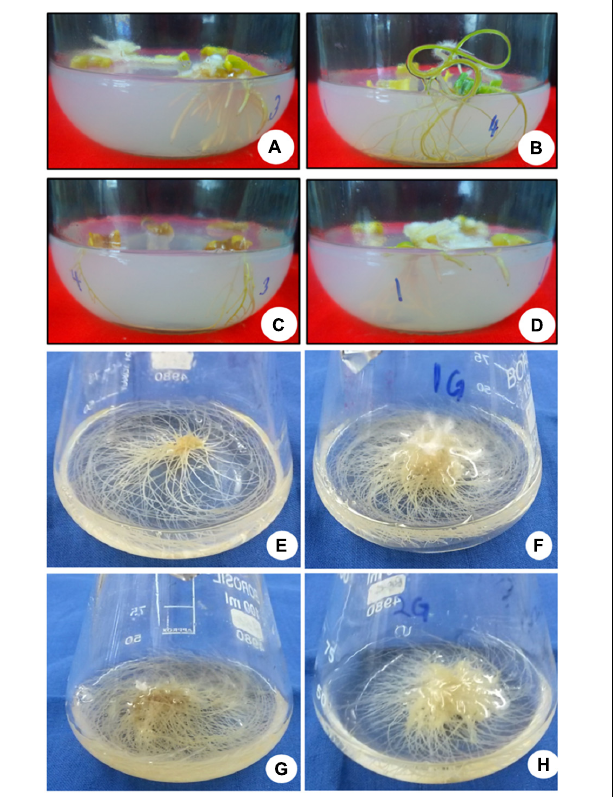
FIGURE 5 | Induction and culture of adventitious roots. (A) Profuse growth of thick ramified roots after 25 days, (B) active root growth observed at 25 days, (C) thin, brittle roots, turned brown after 30 days, (D) thick roots, showing a hint of callogenesis at midrib after 40 days, (E) adventitious roots in MS basal media, (F) roots in MS + 0.5 mg L − 1 indole-3-acetic acid (IAA) + 1.0 mg L − 1 IBA, (G) MS + 0.5 mg L − 1 IAA + 1.0 m gL − 1 IBA + 0.20 mg L − 1